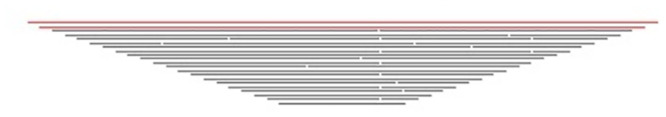
Circle approximation.The concentric circles unrolled and flattened; the sum of their lengths is L = 1.0π + 1.2π + ⋯ + 5.0π. The red solid turns (of lengths 5.0π and 4.8π) are preserved; the black broken ones (of length L′ = 1.0π + 1.2π + ⋯ + 4.6π) are to be reconstructed.